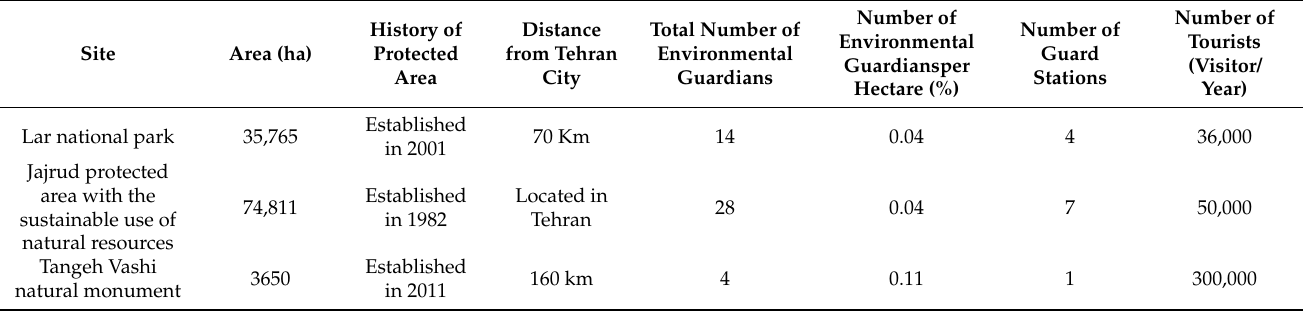
Figure 1. Location of the studied areas; ( a ) Lar national park, ( b ) Jajrud PA, and ( c ) Tangeh Vashi natural monument. Table 1. Description of the three study areas in Tehran